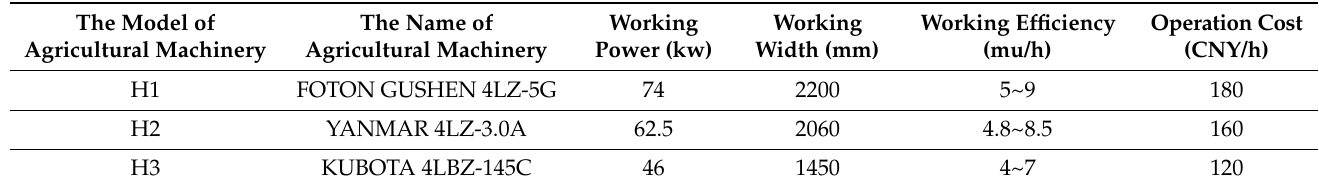
Table 5. The performance parameters and operation cost parameters of different models of agricul- tural machinery.